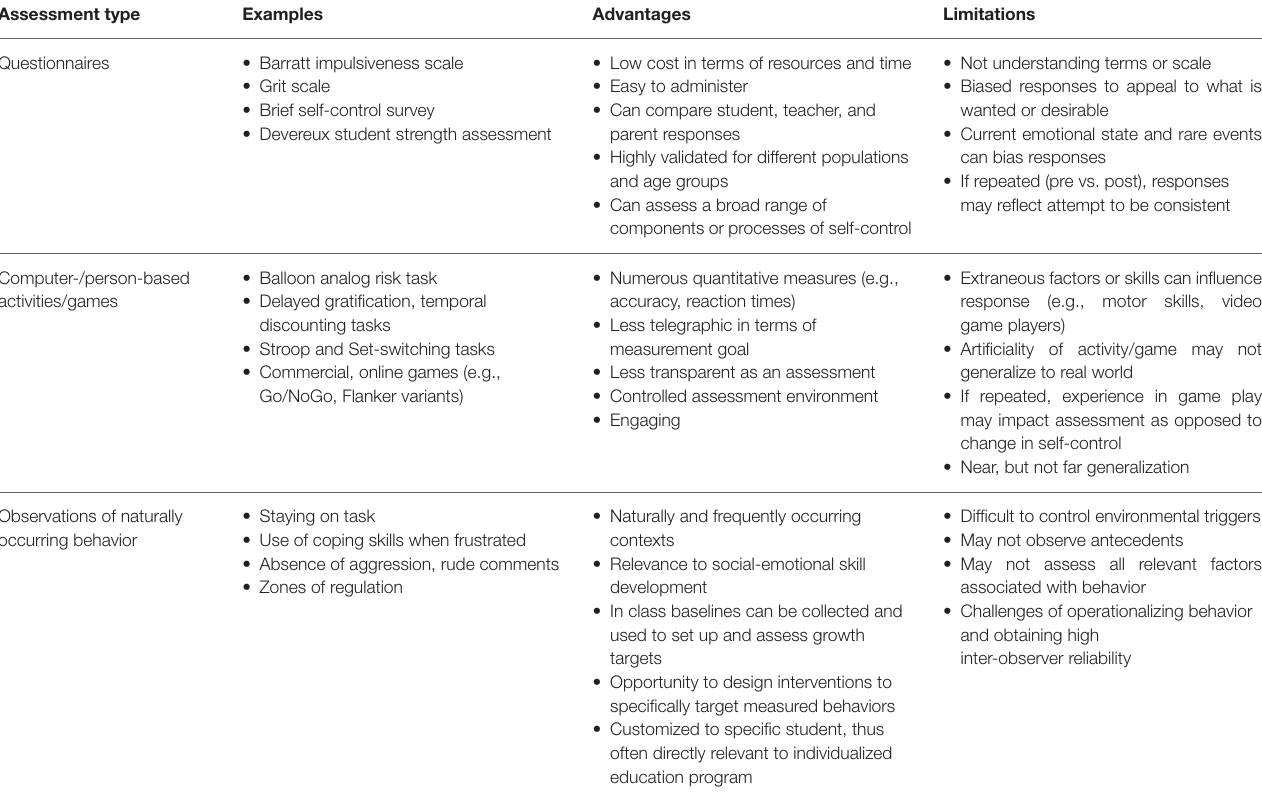
TABLE 1 | Different types of assessments for